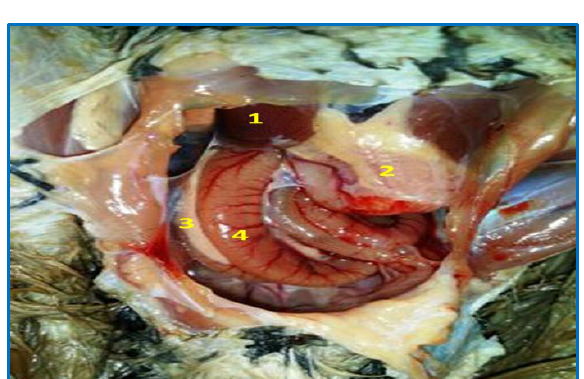
Figure, 1: Shape and position of small intestine of kestrel